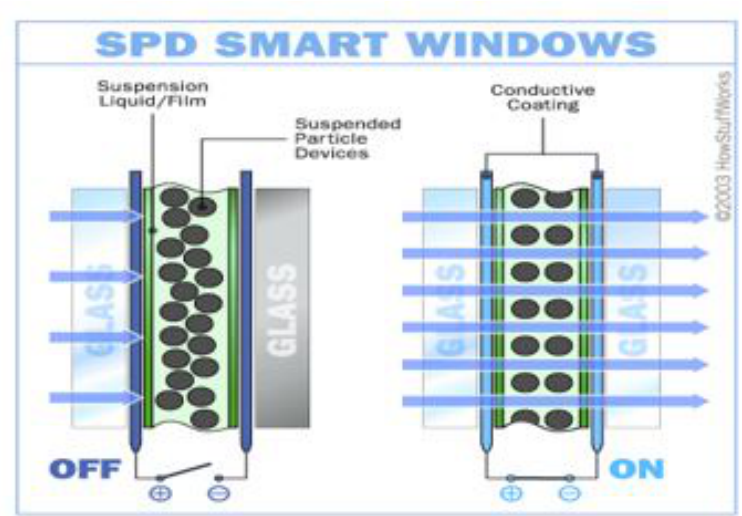
Figure 12. the system of the Suspended particles applied in the windows (”How Smart Windows Work”, 2019)